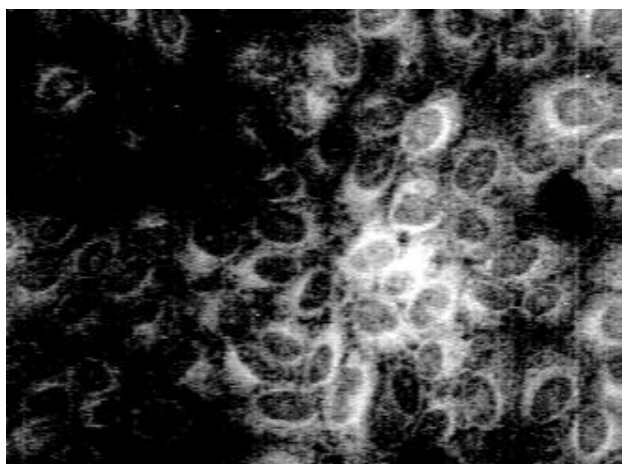
Figure 2. Fluorescence pattern in MDCK-cells after staining with 3b